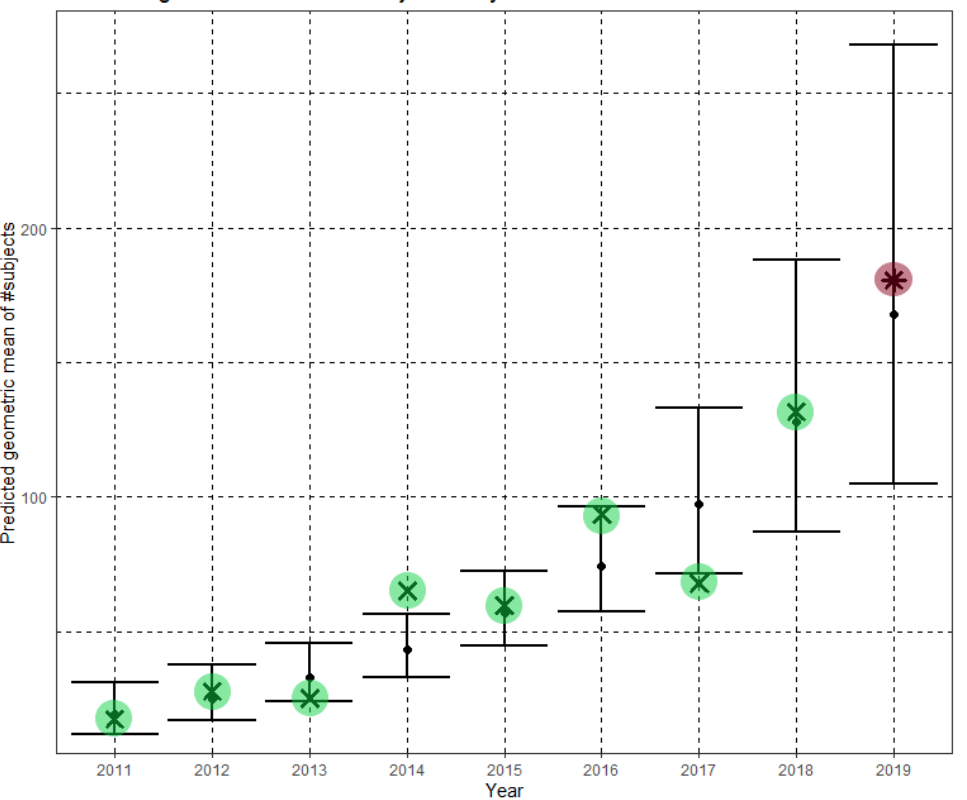
Figure 6. Phase I—Predicted geometric mean (black dots) and confidence intervals of dataset sizes in MICCAI articles involving fMRI for the years 2011–2019, based on the whole ensemble of 2011–2018 fMRI dataset sizes. The empirical geometric means (2011–2018) are shown (in green) for comparison (x marks). The empirical geometric mean for 2019 (in purple) became available later, in Phase II of this research.